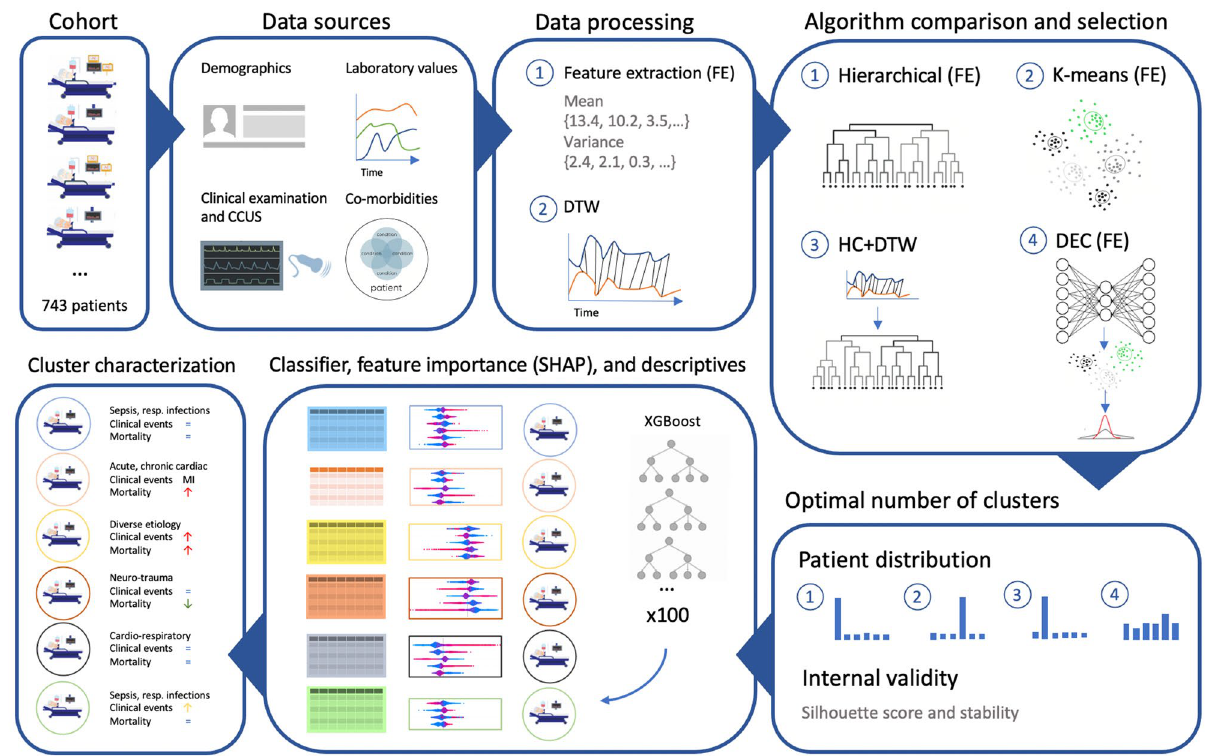
Figure 1. Schematic overview of the different steps in the analysis. Patient selection, integration of different data sources, data processing with feature extraction (FE) or dynamic time warping (DTW), comparison of the four clustering algorithms, selection of the best algorithm based on patient distribution and internal validity measures, training of the classifier for attributing true labels to the clusters and calculating feature importance with SHAP, and cluster characterization based on input data from diagnoses, feature importance, and differences in outcomes including mortality, AKI, and other clinical